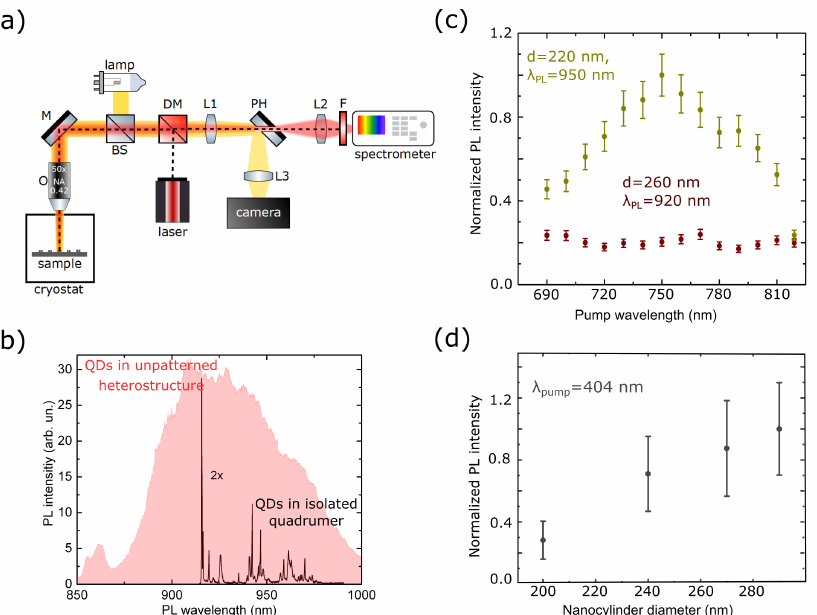
Figure 3. Microphotoluminescence of QDs coupled to GaAs quadrumers for linearly polarized pump beams. ( a ) Experimental setup for microphotoluminescence measurements at cryogenic temperature of 8 K. L1:3 are lenses, O is the objective lens, M is the mirror, BS is the beam splitter, DM is the dichroic mirror, PH is the pinhole coupled to the mirror, F is the set of low pass and long pass filters. ( b ) The red area is the µ -PL spectrum of InAs QDs embedded into the GaAs film, obtained from the 2.5 µ m spot on the sample pumped by laser radiation with 404 nm wavelength. The black curve with a set of emission lines is the representative spectrum of InAs QDs located in the GaAs nanopillars forming isolated quadrumer. ( c ) Experimental photoluminescence intensity normalized to the maximum value for resonant, d ≈ 220 nm (yellow), and non-resonant, d ≈ 260 nm (red), samples measured for different pump wavelengths and fixed PL wavelength ( λ PL ) for each sample ( λ PL = 950 nm and λ PL = 920 nm). ( d ) The dependence of the isolated quadrumer PL intensity on the diameter of nanopillars normalized to its maximum